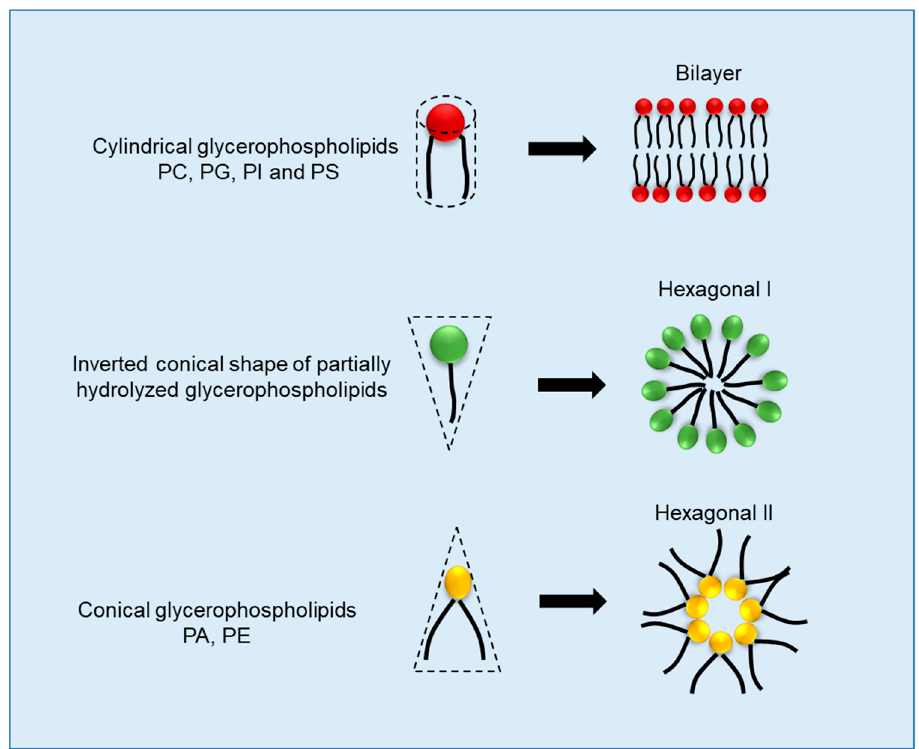
Figure 2. Cell membrane configurations as affected by the lipid composition. The relative width of the polar head group and fatty acid chains determines the shape of glycerophospholipids. Cylin- drical lipids configure membranes in a bilayer shape, inverted conical in hexagonal I, and conical glycerophospholipids in hexagonal II. Diagram is adopted from Zhukovsky et al. [43].